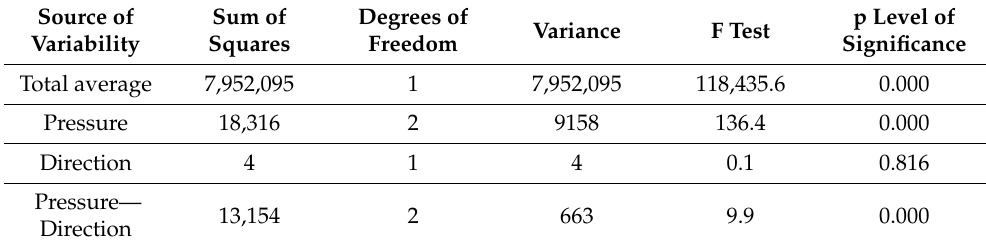
Table 4. Two-way ANOVA—bending strength.